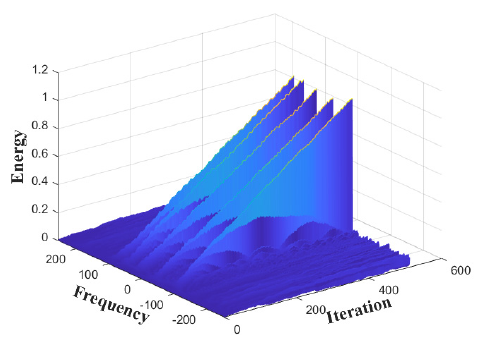
Figure 3. The result of the frequency accumulation.